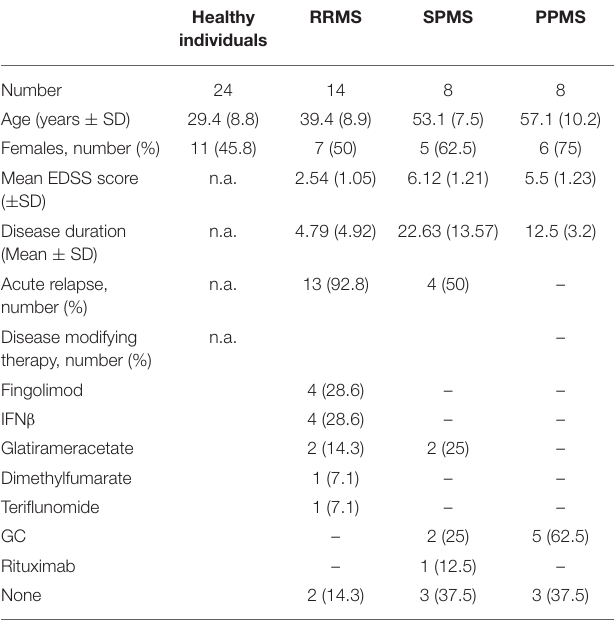
TABLE 1 | Summary of the characteristics of patients and healthy individuals included in the study. Healthy RRMS SPMS individuals